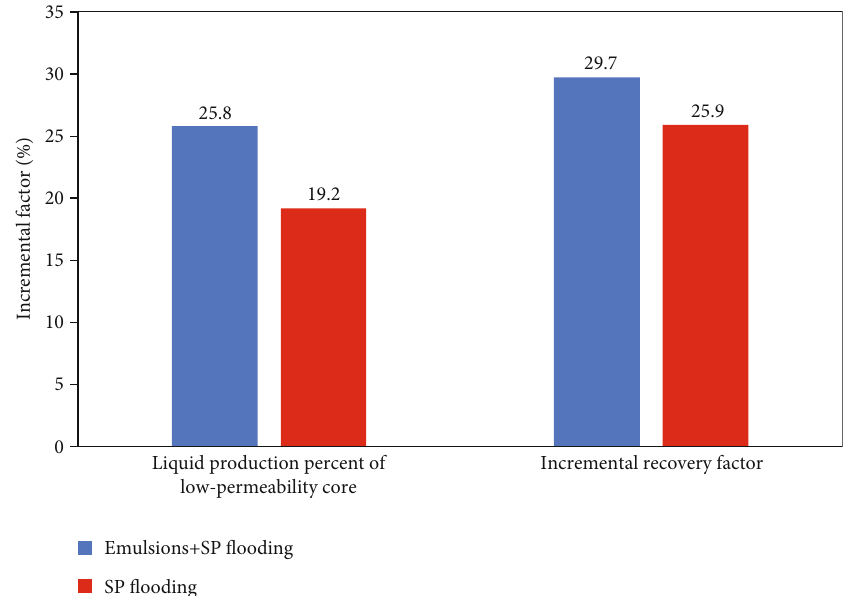
Figure 6: Liquid production percent of low-permeability core and incremental recovery factors of two experimental schemes.